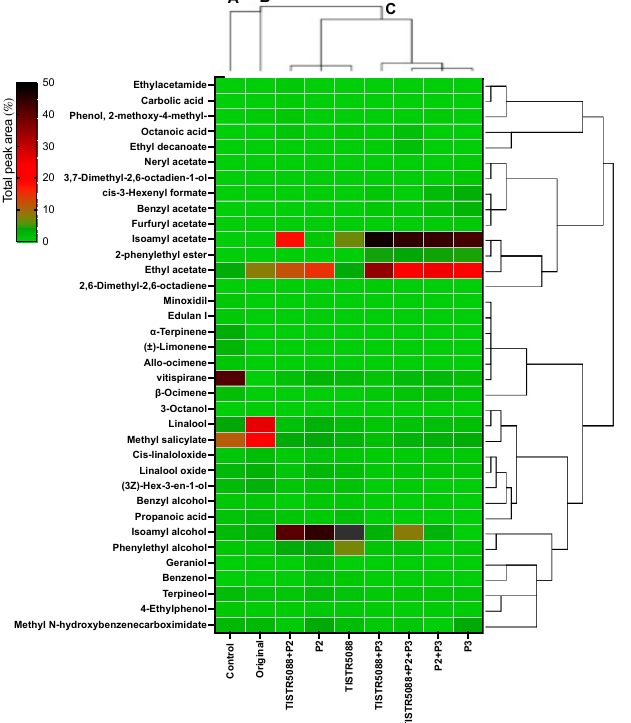
Figure 10. Heatmap and hierarchical cluster analysis representation corresponding to the 36 volatile compounds of original and fermented MF-broth inoculated with S. cerevisiae TISTR 5088, W. anomalus P2 and C. rhodanensis P3 at 30 °C for 120 h.